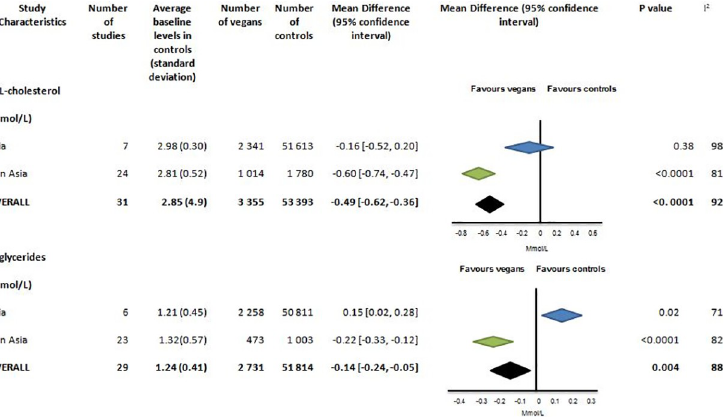
Fig 6. Low density lipoprotein cholesterol and triglycerides (mmol/L) in vegans compared to